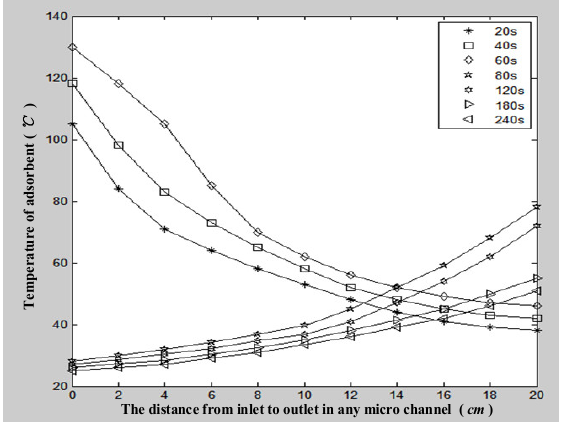
Figure 6. Change in adsorbent temperature at various points along the channel direction.